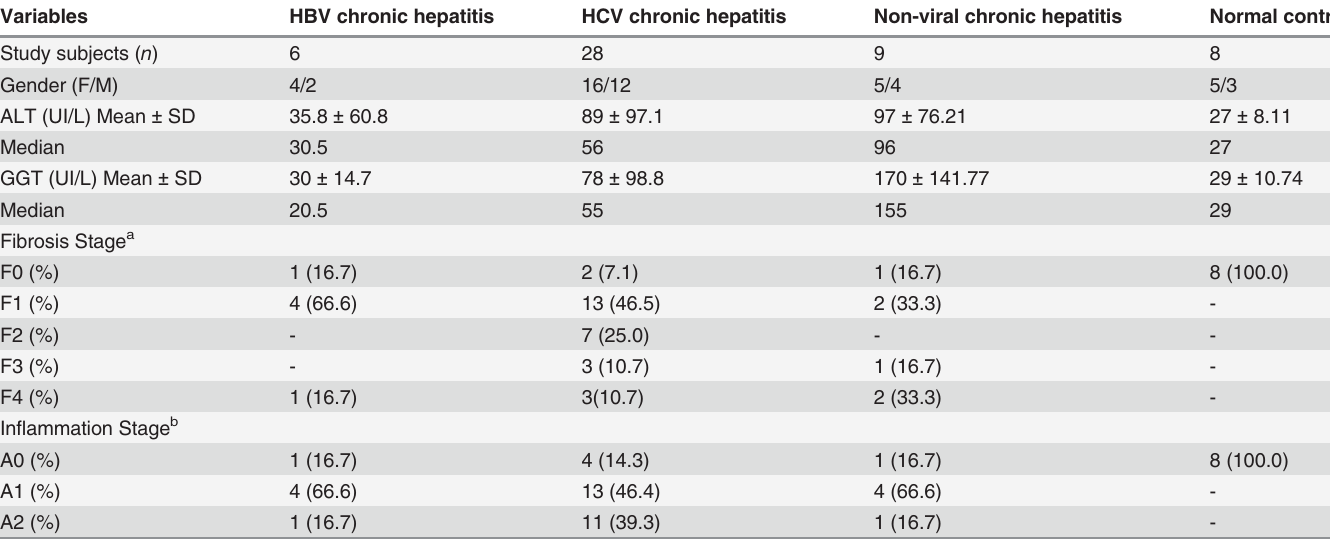
Table 1. Clinical and laboratory information study participants with and without HBV and HCV, with different degrees of disease. Variables HBV chronic hepatitis HCV chronic hepatitis Non-viral chronic hepatitis Normal